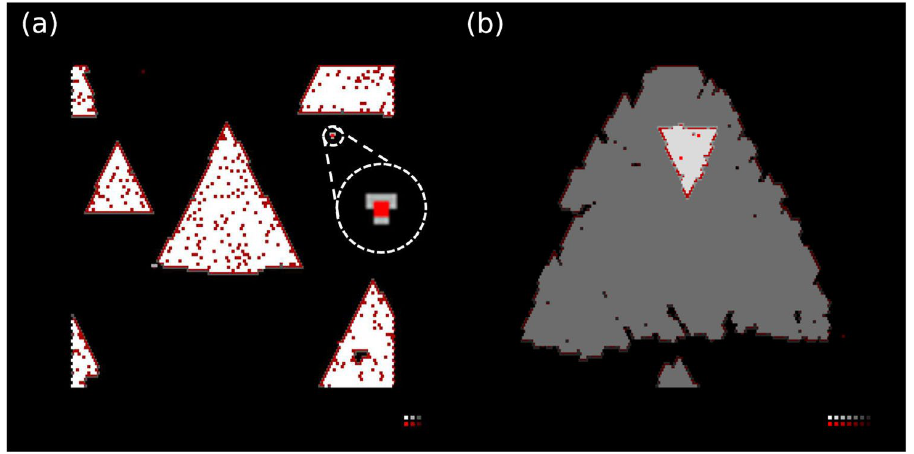
Figure 5. Examples of homogeneous nucleation on the substrate ( a ) and on another layer of TMD ( b ). The form of an initial nucleus (circled in ( a ) with a dashed circle) is zoomed in. Each pixel represents an atom color- coded by element (red: metal, gray: chalcogen) and the height is represented by brightness, as shown in the legend on the bottom right